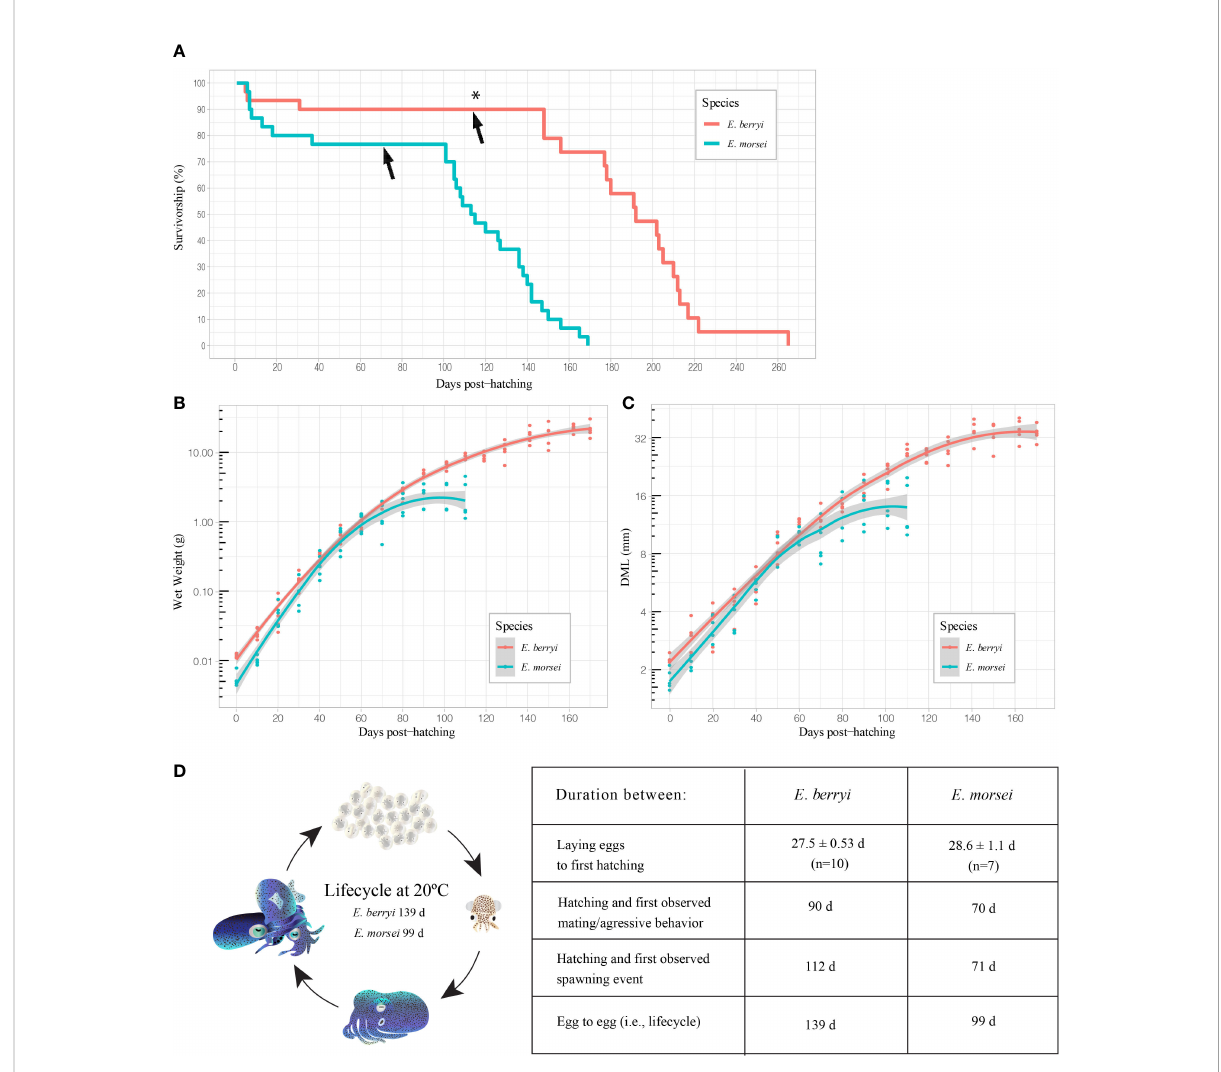
FIGURE 3 Survivorship, growth rate, and developmental timelines for E berryi and E morsei. (A) Survivorship for each species. For each species, initial population size was 30 individuals. The asterisk (*) represents an arti fi cial reduction in total population size for E berryi from 30 to 19 individuals due to limited tank space. Arrows indicate the fi rst spawning event for each species. (B) Growth rate comparing wet weight (g) to dph on semi- log scale. (C) Growth rate comparing dorsal mantle length (mm) to age on semi-log scale. (D) Comparison of the lifecycle and time between developmental landmarks of both E berryi and E morsei